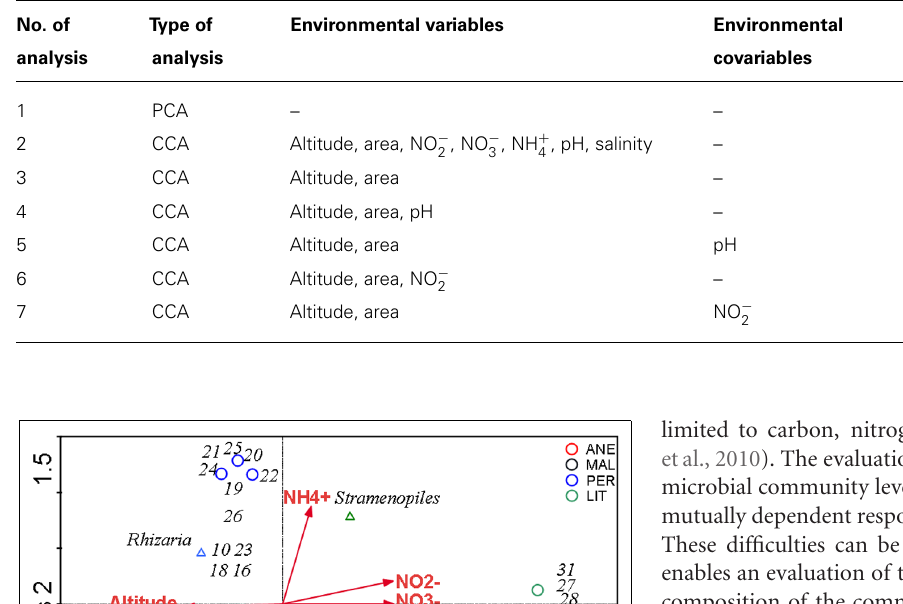
Table 6 | Summary of correspondence analysis and eigenvalues ( λ ).